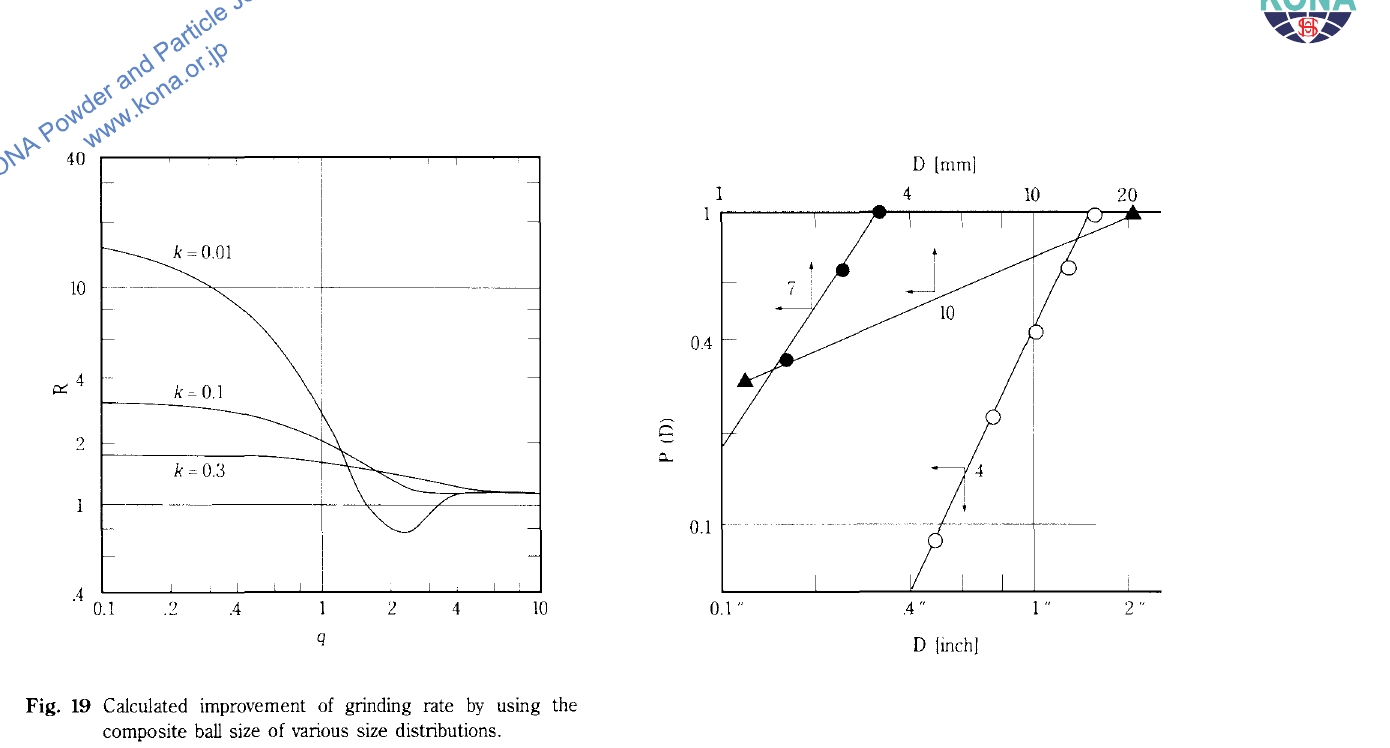
Fig. 20 Gaudin-Schuhman plot of ball size distribution, to deter mineq grinding. The strength of a material 0'